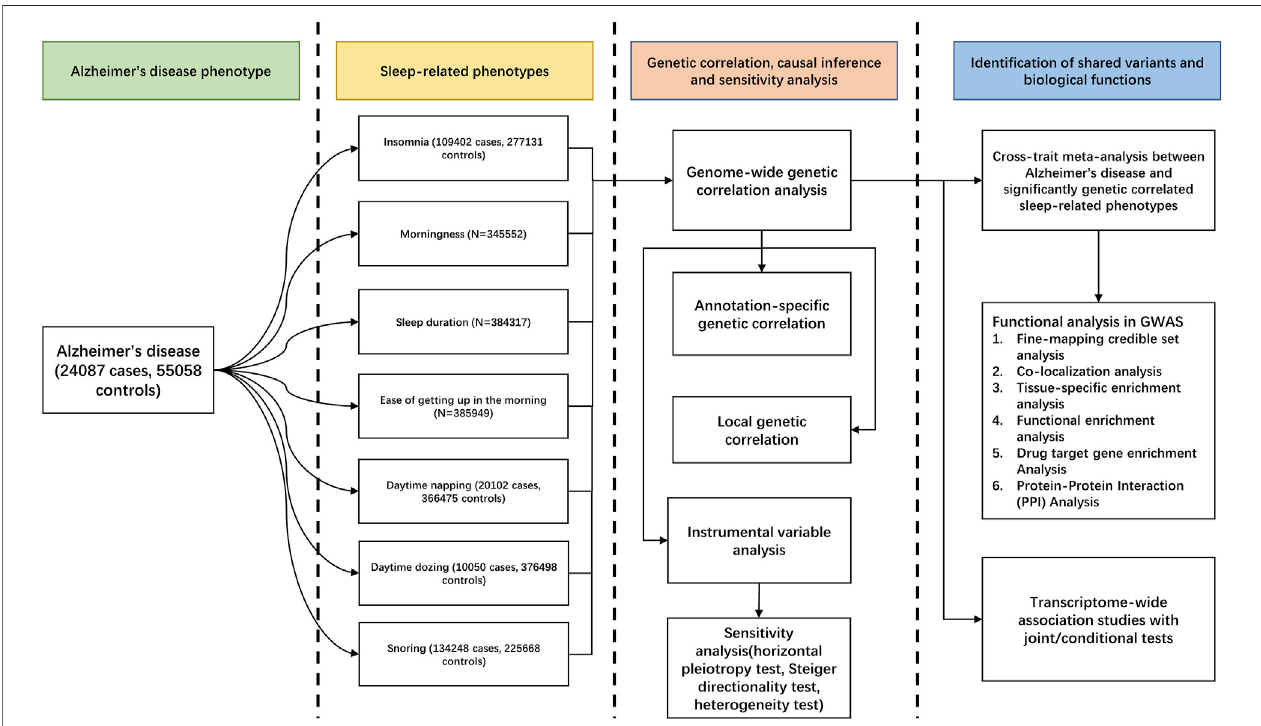
FIGURE 1 | Work fl ow of the